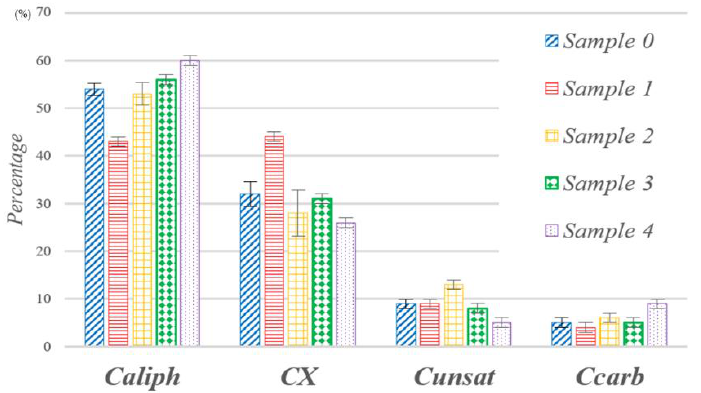
Figure 3 . Relative distribution, expressed as percentage (%), of the carbon groups C aliph , C X , C unsat and C carb for the Samples 0, 1, 2, 3, and 4 at 12 h.